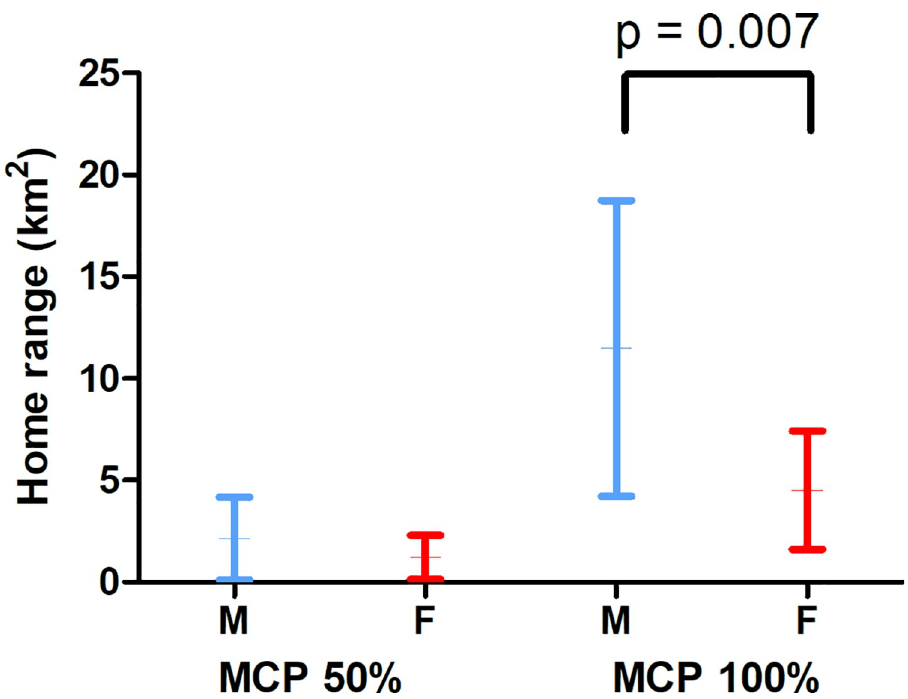
Fig 2. Average ± SD home range sizes (MCP50% and 100%) of the Saimaa ringed seals. Adult males (M) had statistically larger total home ranges (100%) than those of the females (F), but the core area sizes (MCP50%) were